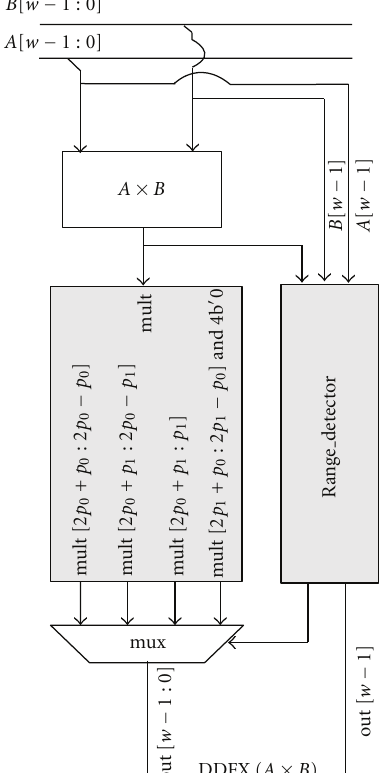
Figure 5: Dual fixed-point multiplier’s block diagram. The components that need to be reconfigured to enable a change in precision in a dynamic dual fixed-point multiplier are shown in